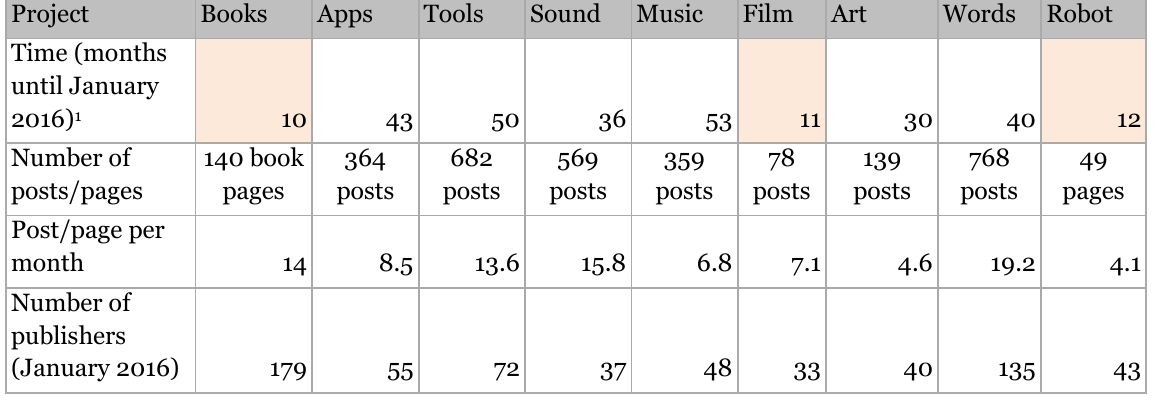
Production in the Communities’ Websites in Terms of Publications Created Per Month Project